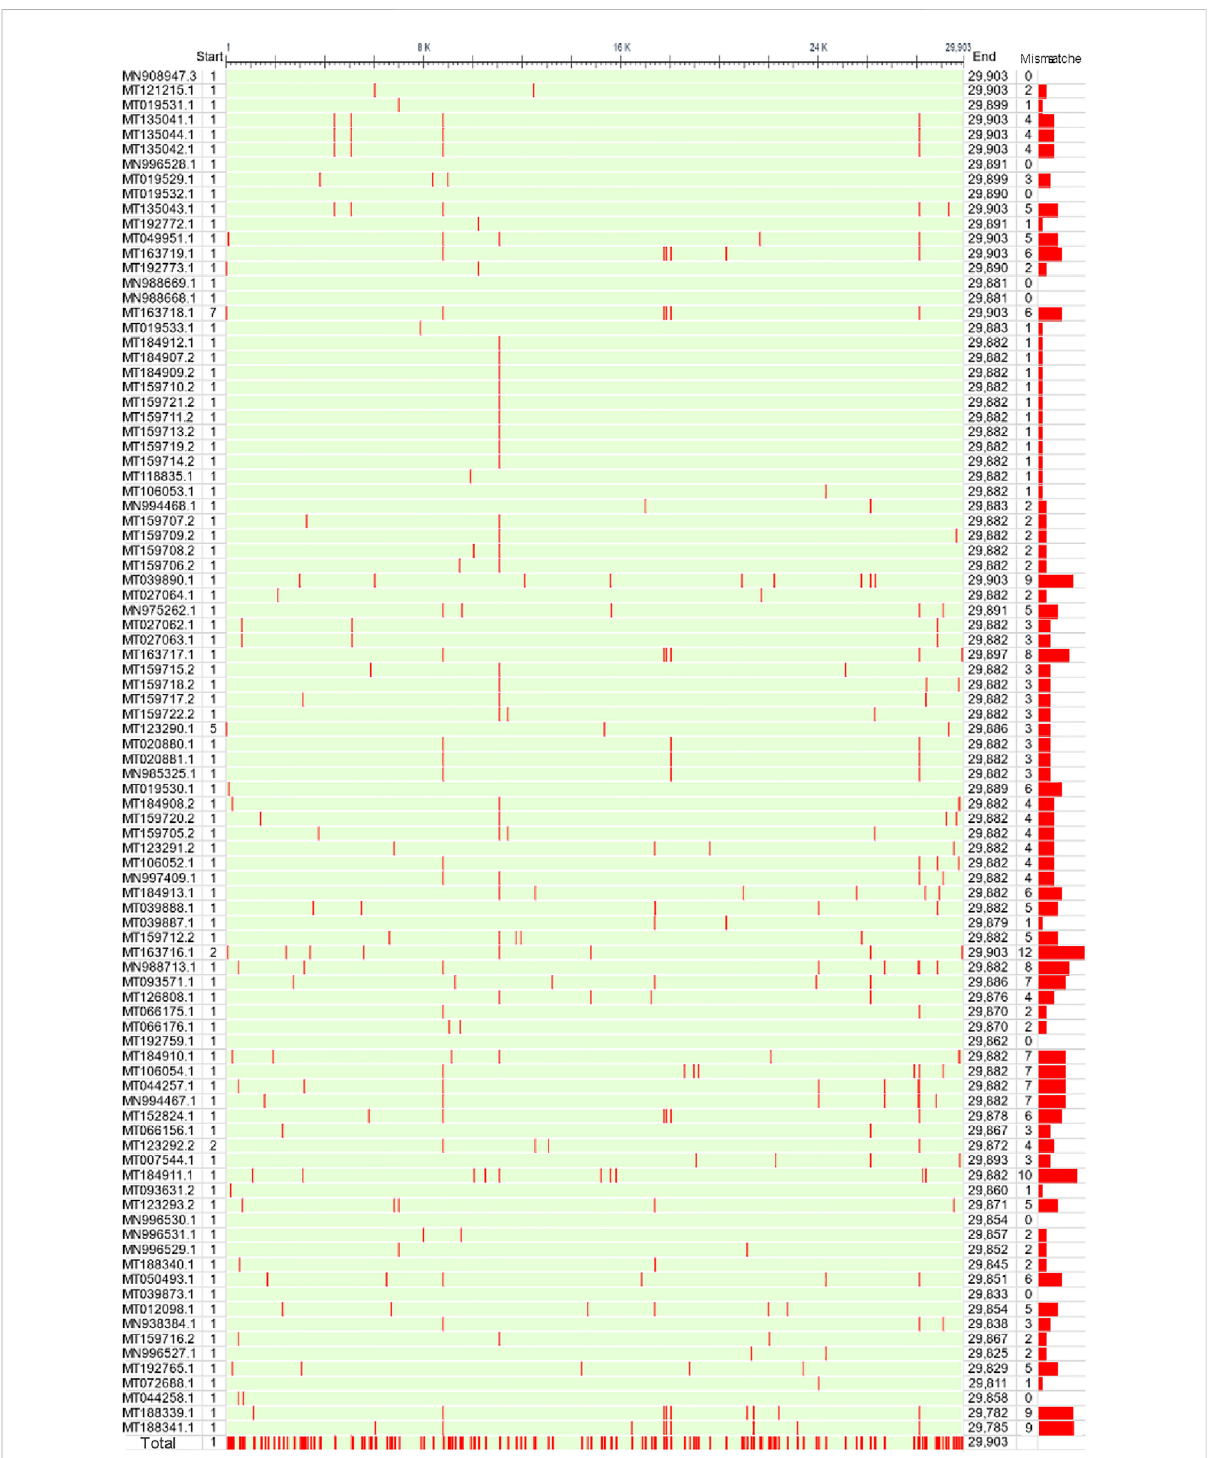
Sequence alignment of 92 full-lengthSARS-CoV-2 genomes. The fi rst reported genome (MN908947.3) in Wuhan city was used as a reference. The bar on the right represents the total number of mutated bases for each genome. The bottom line converged all the mutation sites of 92 SARS- CoV-2